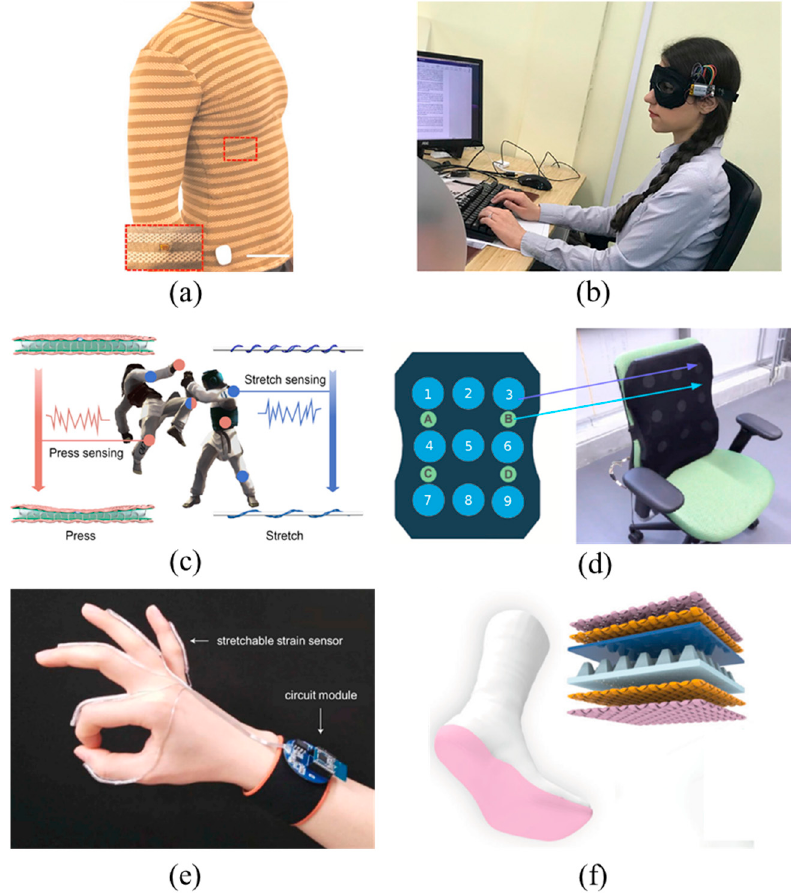
Figure 5. Applications: ( a ) smart clothing applied to health monitoring, reproduced with permission from [104]; ( b ) smart eye mask applied to health monitoring, reproduced with permission from [105]; ( c ) smart clothing applied to motion analysis, reproduced with permission from [106]; ( d ) smart cushion applied to sitting analysis, reproduced with permission from [107]; ( e ) smart glove applied to sign language recognition, reproduced with permission from [108]; and ( f ) smart socks applied to human-machine interaction, reproduced with permission from ref. [109].